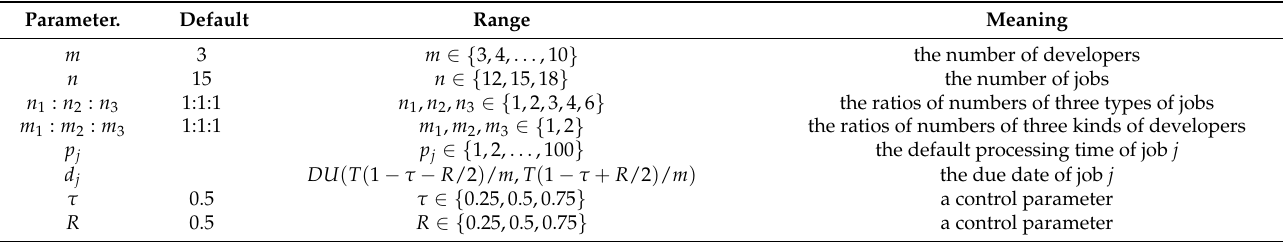
Table 3. The parameters used in the experiments.